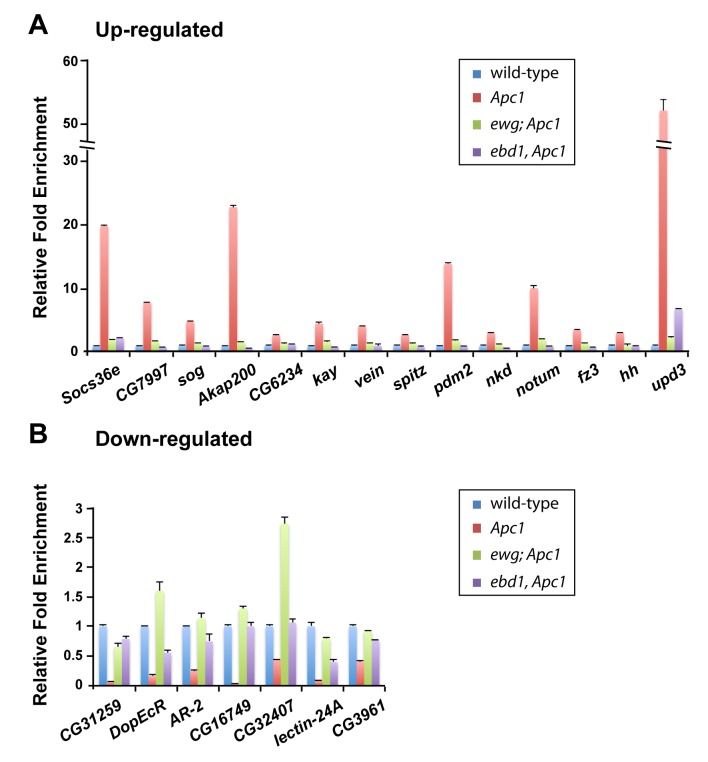
Deregulation of gene expression in the midgut upon loss of Apc1 requires Ebd1 and Ewg.Quantitative RT-PCR of genes up- (A) or down-regulated (B) following loss of Apc1. Deregulation of both sets of genes is rescued in ebd1 Apc1 and ewg Apc1 double mutants. Genotypes: control:
Apc1Q8/+
Apc1:
Apc1Q8
ebd1 Apc1:
ebd1240
Apc1Q8
ewg Apc1:
ewgP1; Apc1Q8.